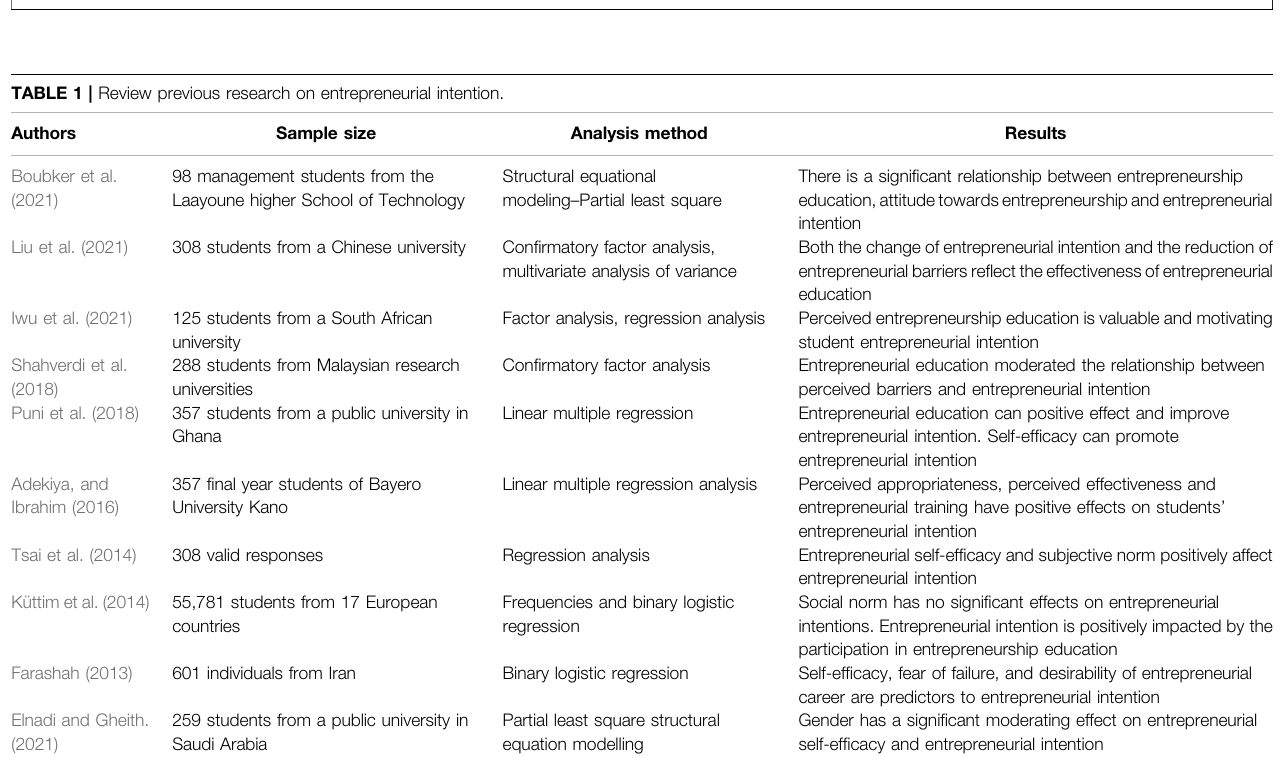
FIGURE 1 | The conceptual framework.